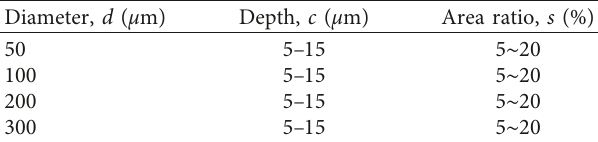
Figure 3: The self-made test machine. Table 1: The textured parameters of the port